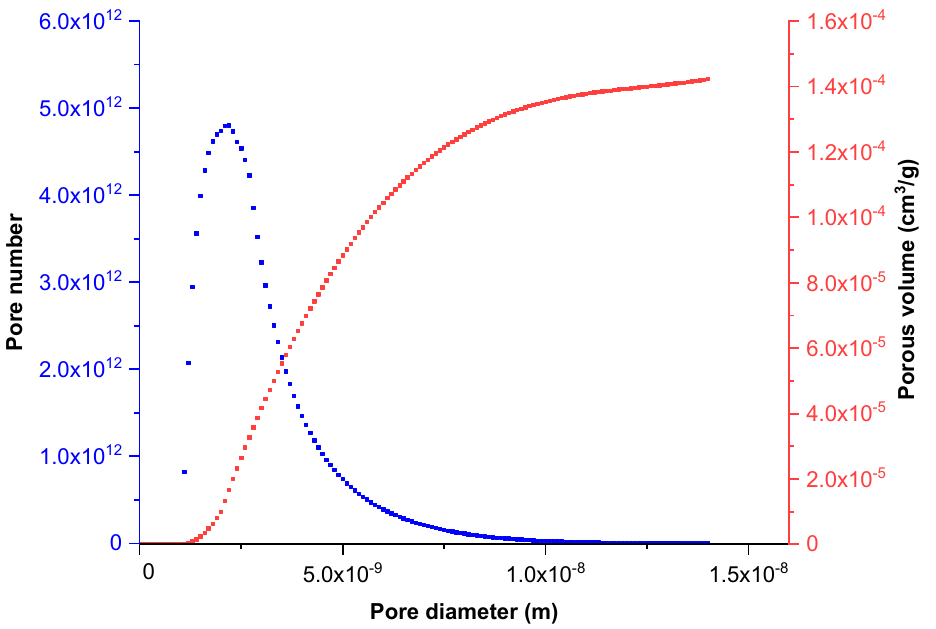
Figure 1. Cumulative porous volume (red curve) versus pore diameter and pore size distribution (blue curve).